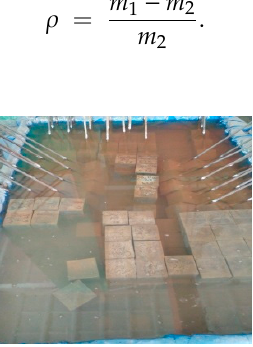
Figure 3. Specimens cured under water in tank.